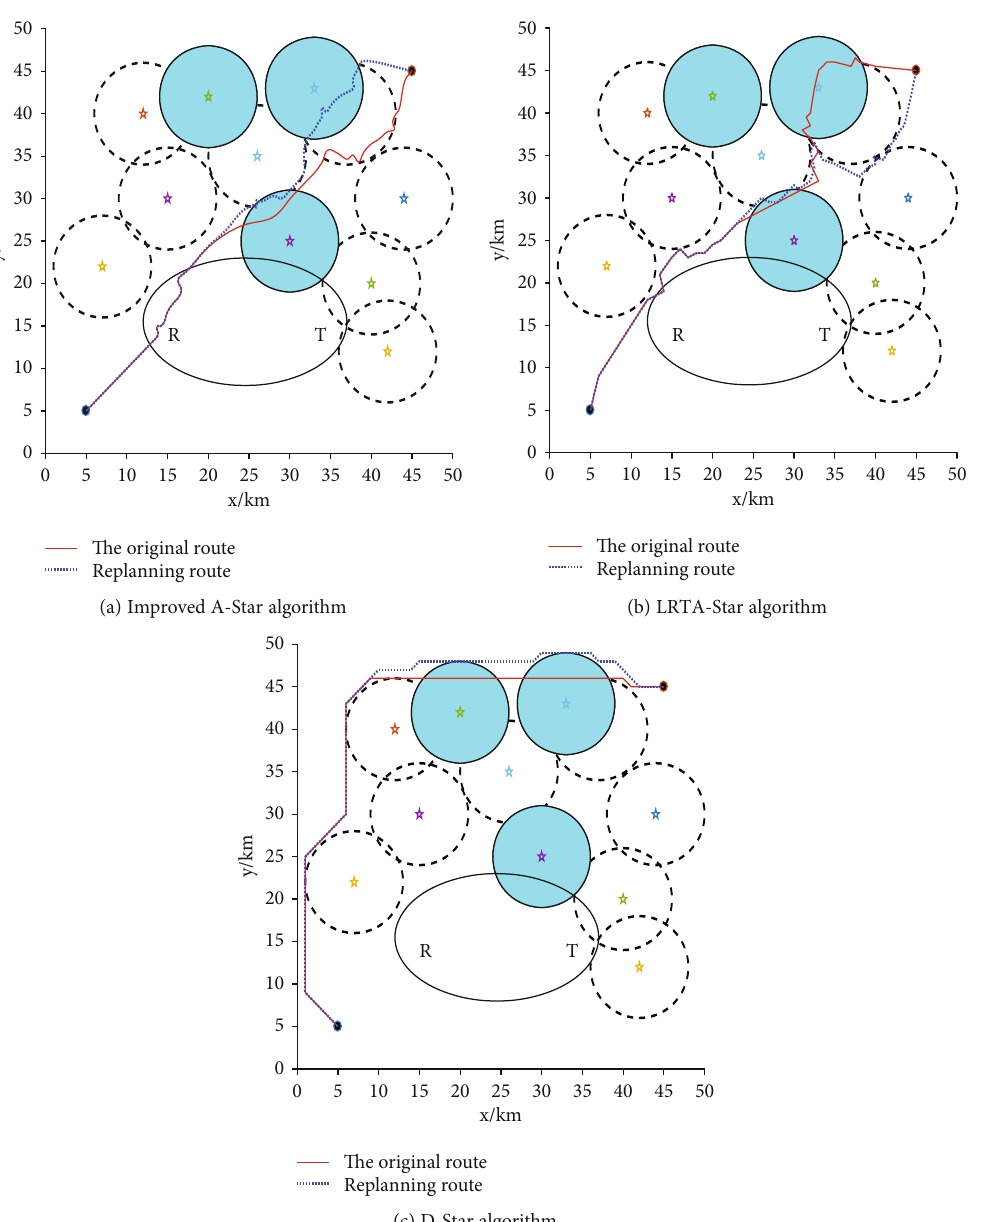
Figure 11: Numerical results of penetration path planning in the third